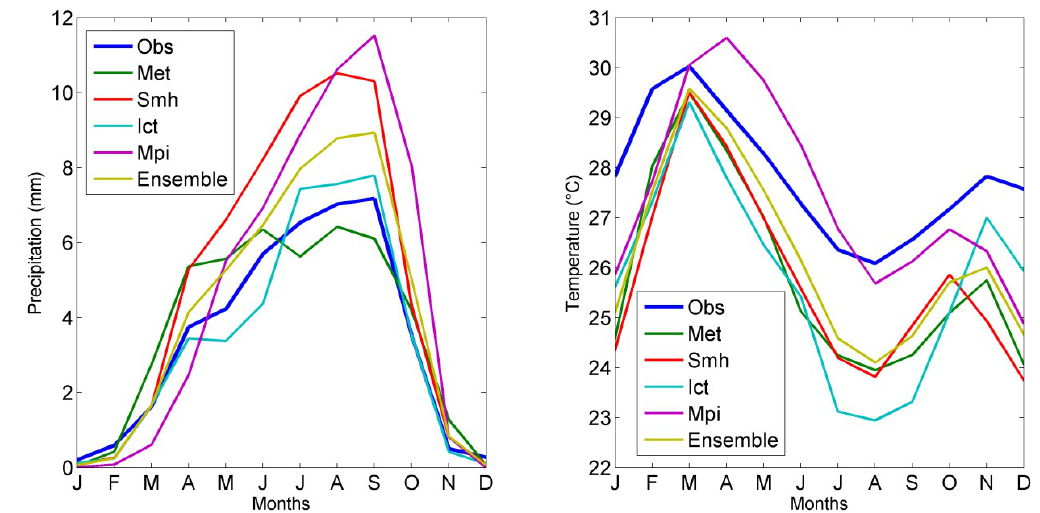
Figure 6. Comparison of the observed and simulated rainfall (mm/day) and air temperature (°C) regimes in the Mono river basin at the Nangbéto outlet (1988–2010 average).